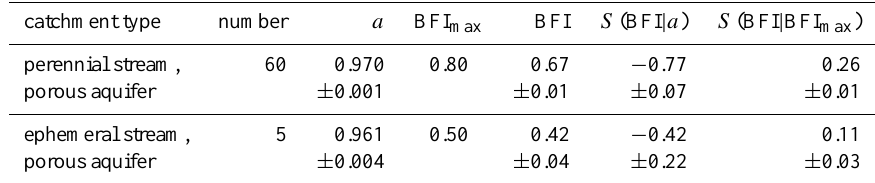
Table 1. Results of the analysis of 65 North American catchments (mean values and their standard deviation). catchment